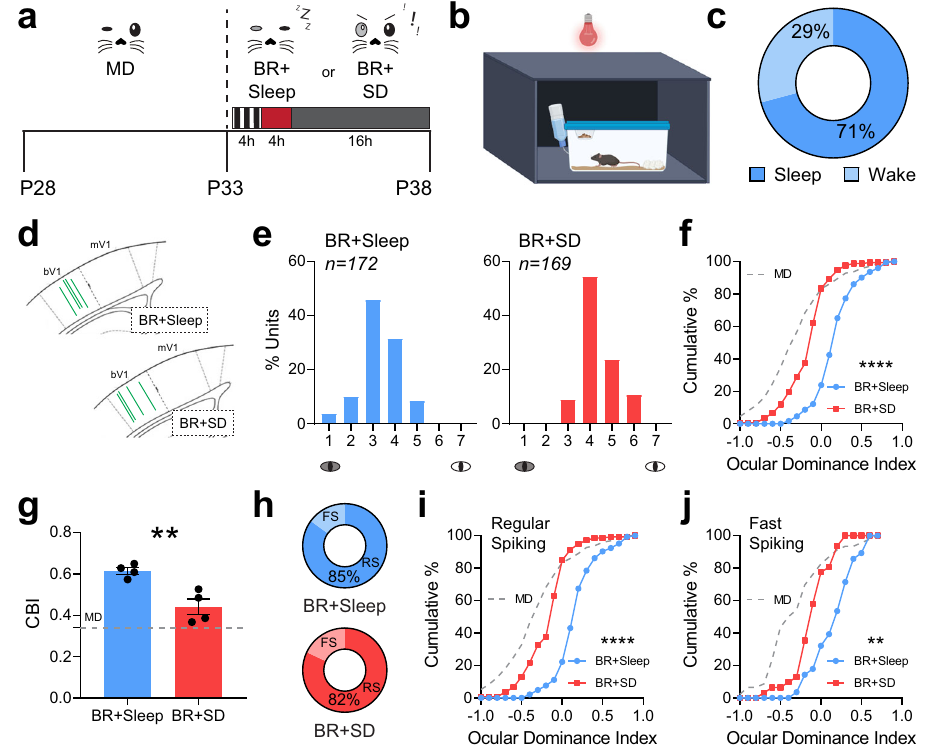
Fig. 4 Sleep loss following BR visual experience prevents ocular dominance shifts. a Experimental design. Mice underwent 5-day MD and 5-day BR; each day after 4-hr BR, BR + Sleep mice were returned to their home cage and allowed ad lib sleep under dim red light, BR mice underwent 4 h of sleep deprivation (BR + SD) through gentle handling under dim red light. b Schematic of experimental setup for animal observation under dim red light. c On average, BR + Sleep mice spent 71% of the 4 h period following visual enrichment ( n = 4) in sleep, based on visual con fi rmation of immobility, stereotyped (crouched) sleep postures, nesting, and closed eyes, consistent with prior studies 83,102 – 104 . d Schematic of bV1 coordinates in coronal sections. Green lines indicate probe placements in bV1 for BR + Sleep and BR + SD groups. e Ocular dominance histograms for bV1 neurons recorded from BR + Sleep and BR + SD groups (4 mice/group). f Cumulative distribution of ocular dominance index values for bV1 neurons recorded from BR + Sleep and BR + SD mice. Values from neurons recorded in MD-only mice from Fig. 1 are shown (dashed gray lines) for comparison. g Contralateral bias index values were reduced for bV1 neurons recorded from BR + SD mice. Unpaired t-test: p = 0.0059. Error bars indicate mean ± SEM. h Proportion of recorded neurons identi fi ed as RS neurons or FS interneurons for the two groups. RS neurons: BR + Sleep ( n = 144); BR + SD ( n = 138). FS interneurons: BR + Sleep ( n = 28); BR + SD ( n = 31). i , j Ocular dominance index values for recorded RS neurons ( i ) and FS interneurons ( j ) were reduced in BR + SD mice. ** and **** indicate p < 0.01 and p < 0.0001, K-S